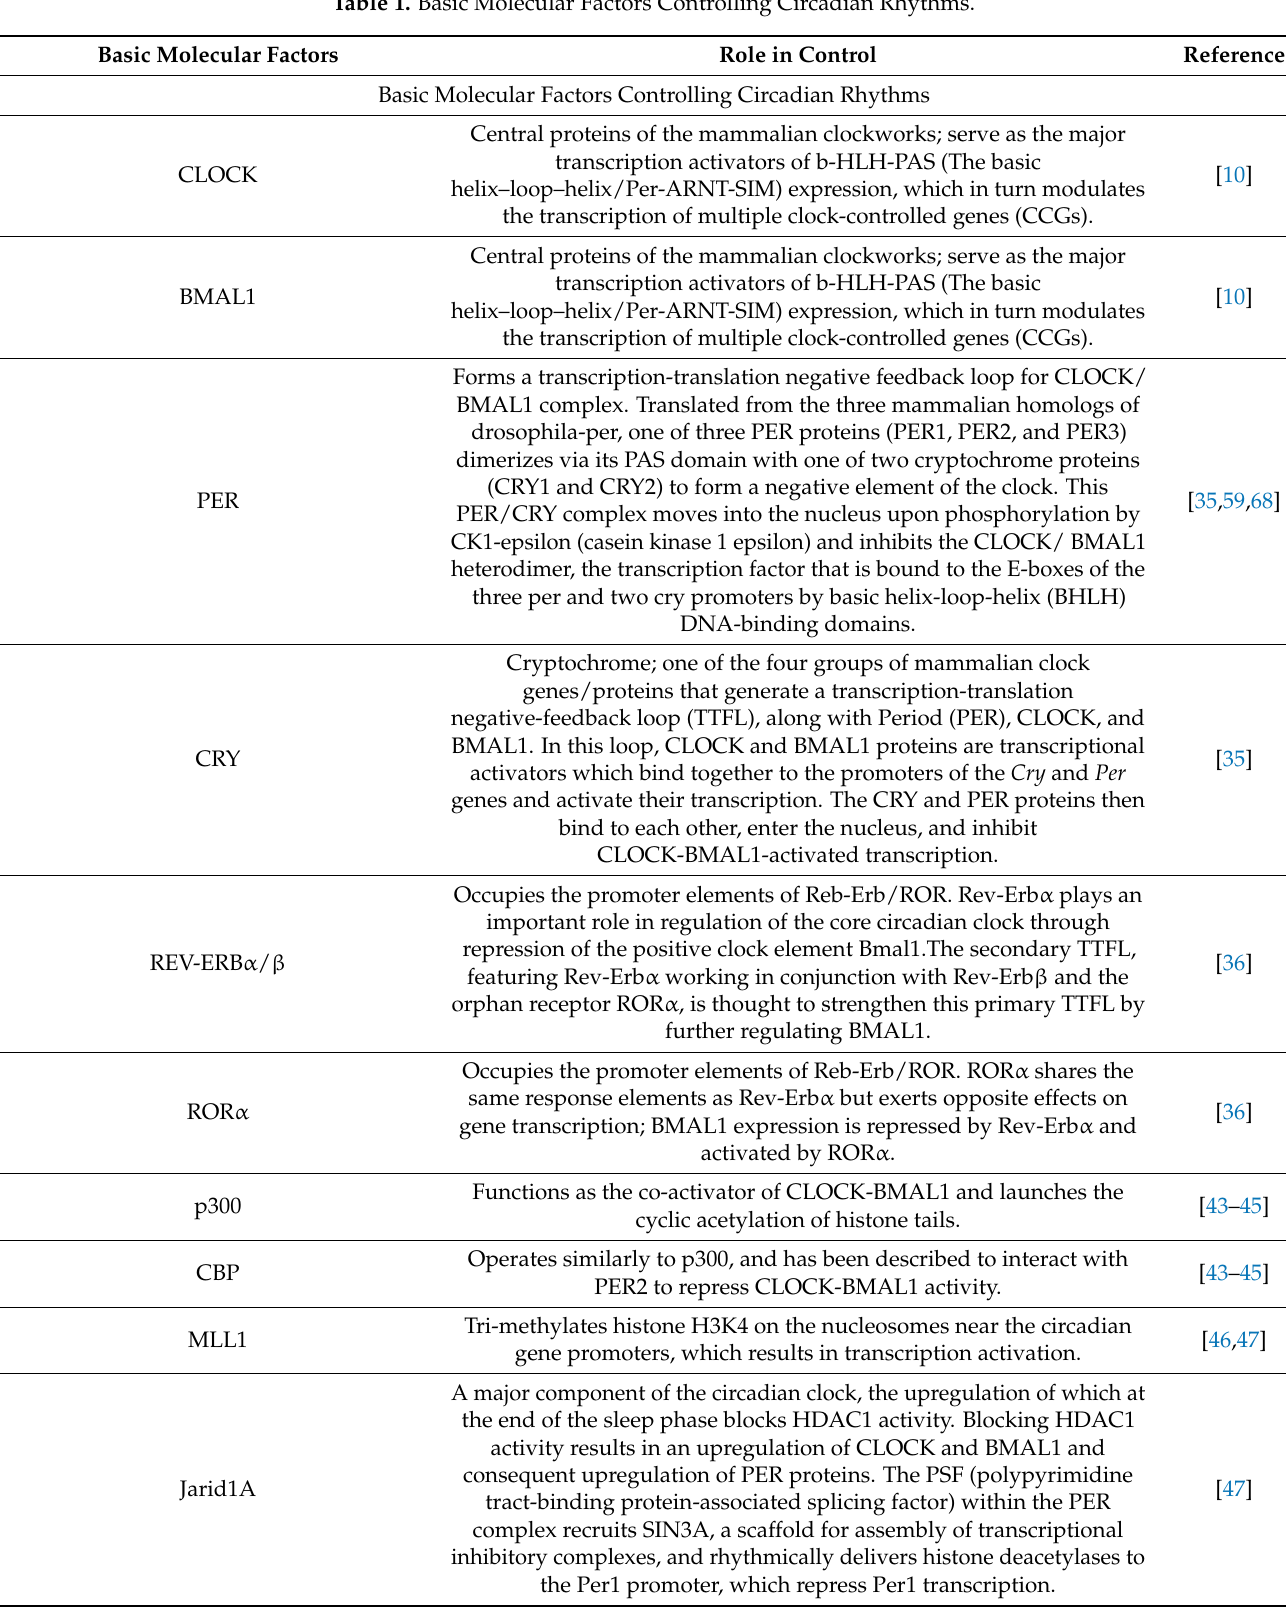
Table 1. Basic Molecular Factors Controlling Circadian